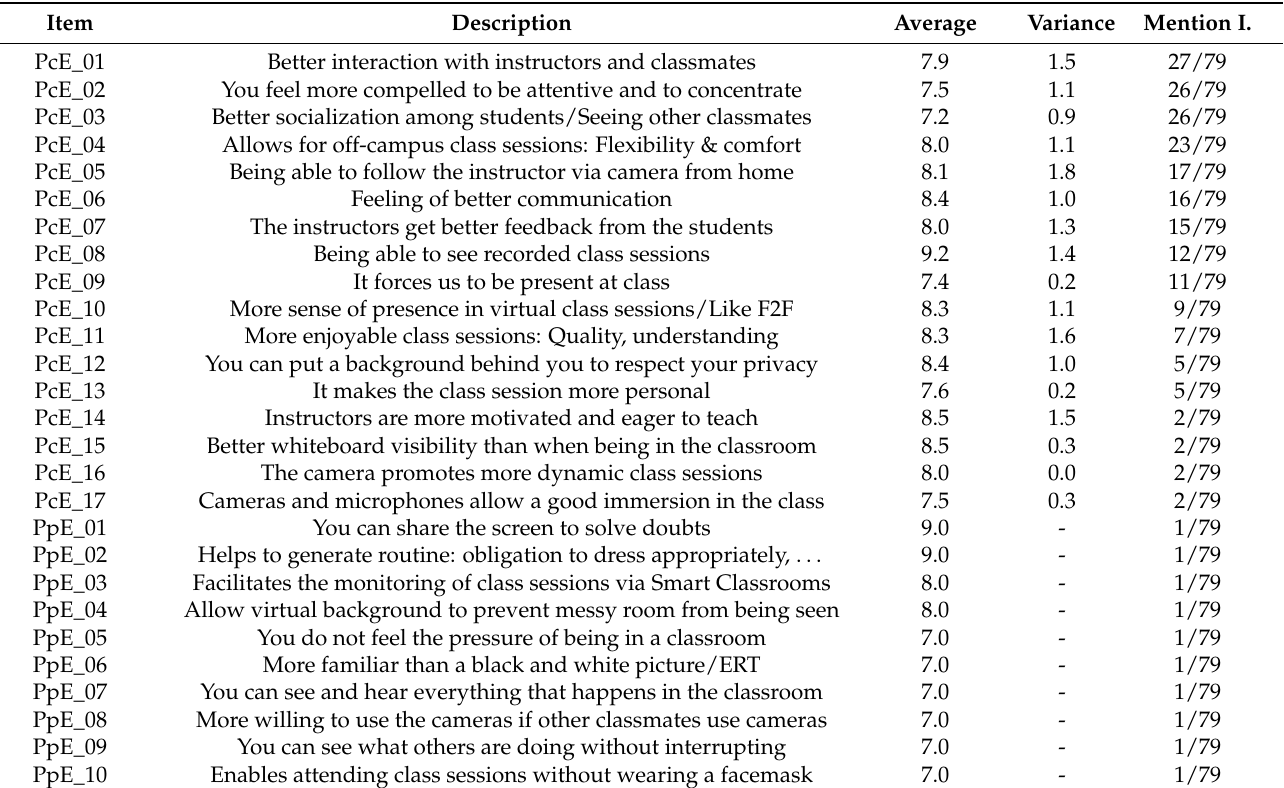
Table 1. Positive (P) common (c) and particular (p)